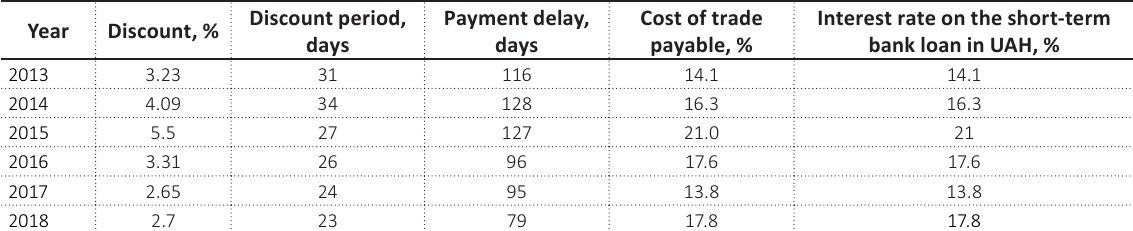
Source: Calculated by the author.